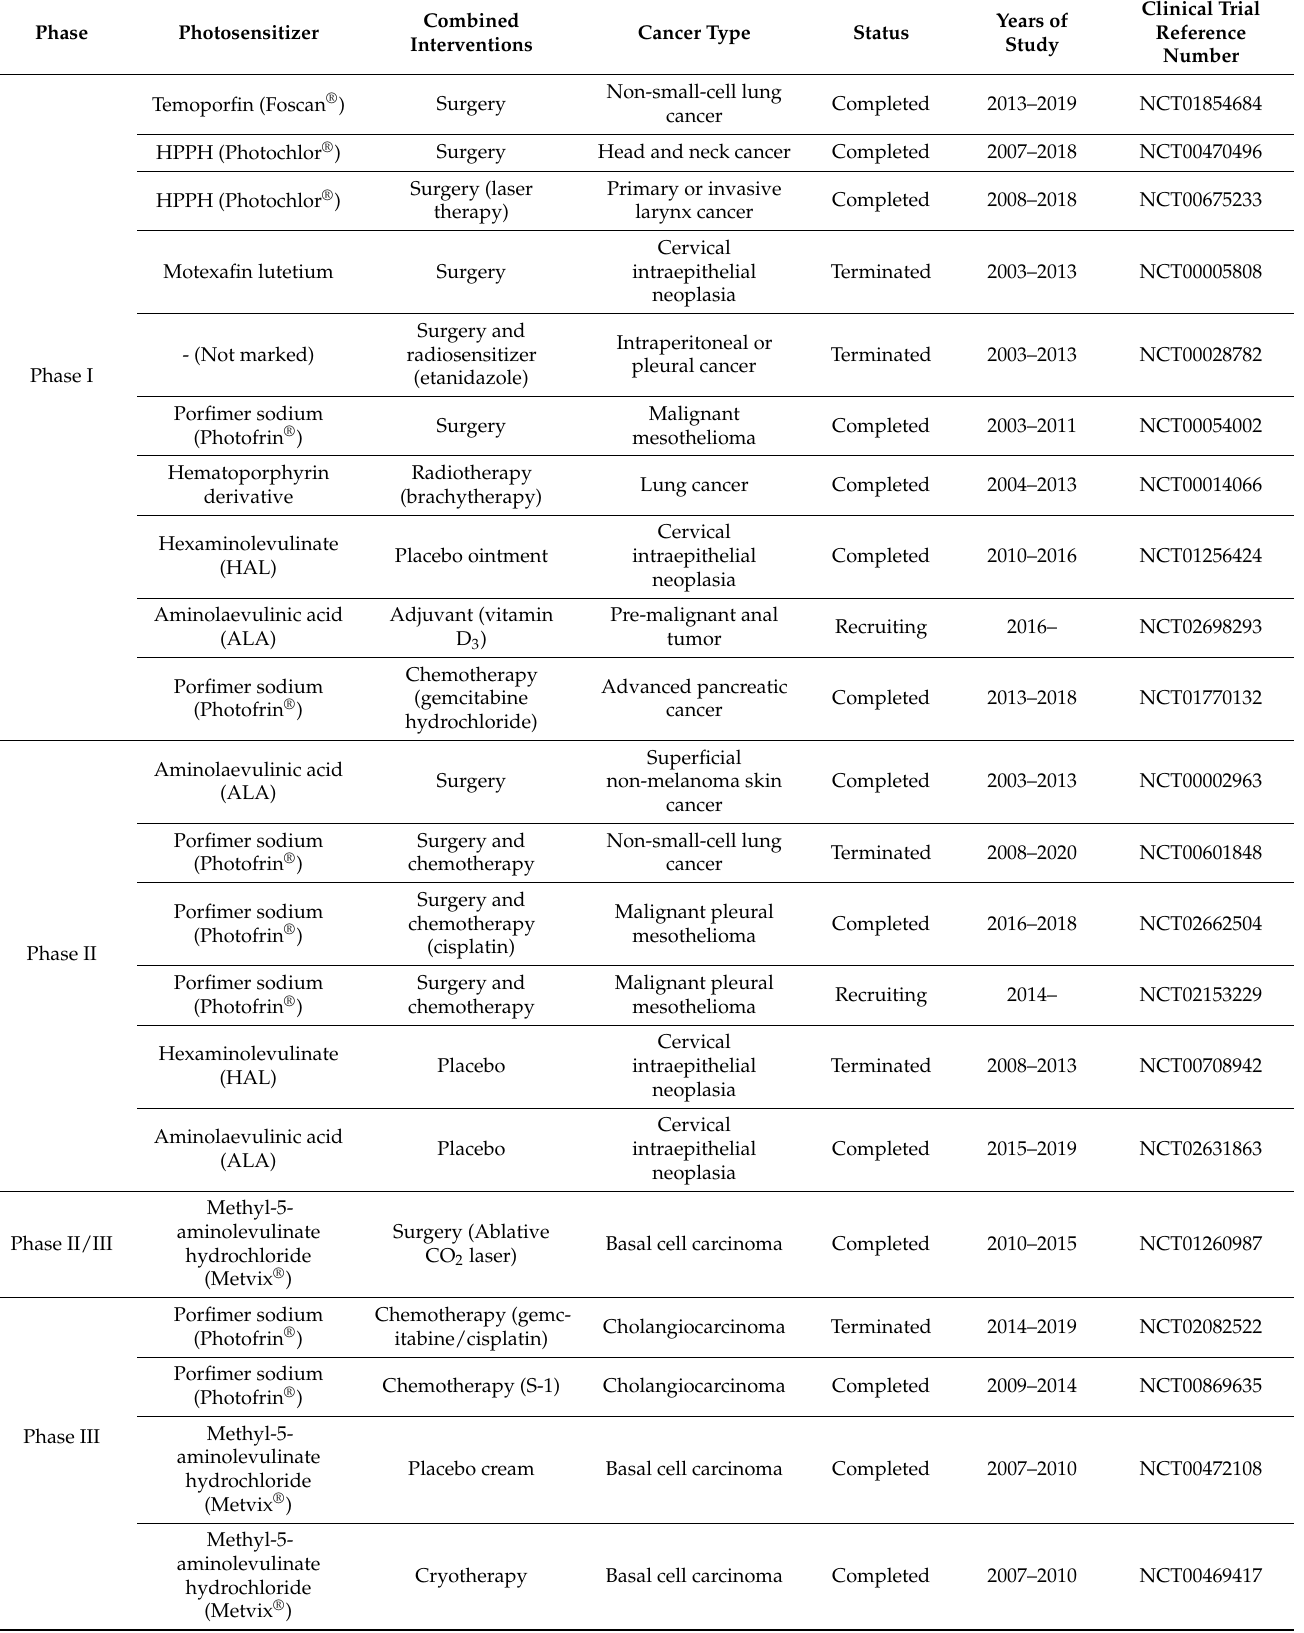
Table 1. Clinical trials of photodynamic therapy-based combination